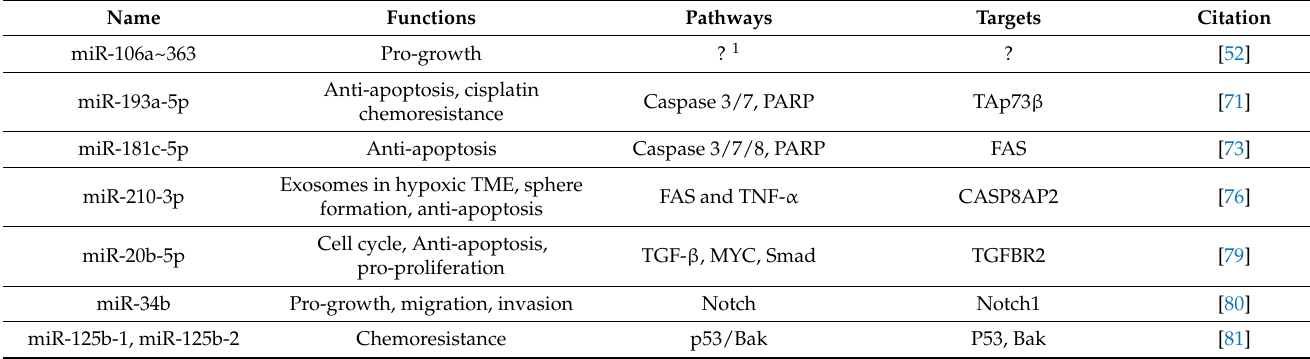
Table 2. MicroRNAs in Ewing’s Sarcoma with Oncogenic